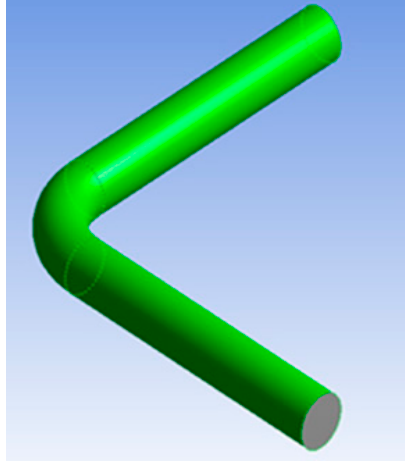
Figure 3. The model diagram of the elbow in references.